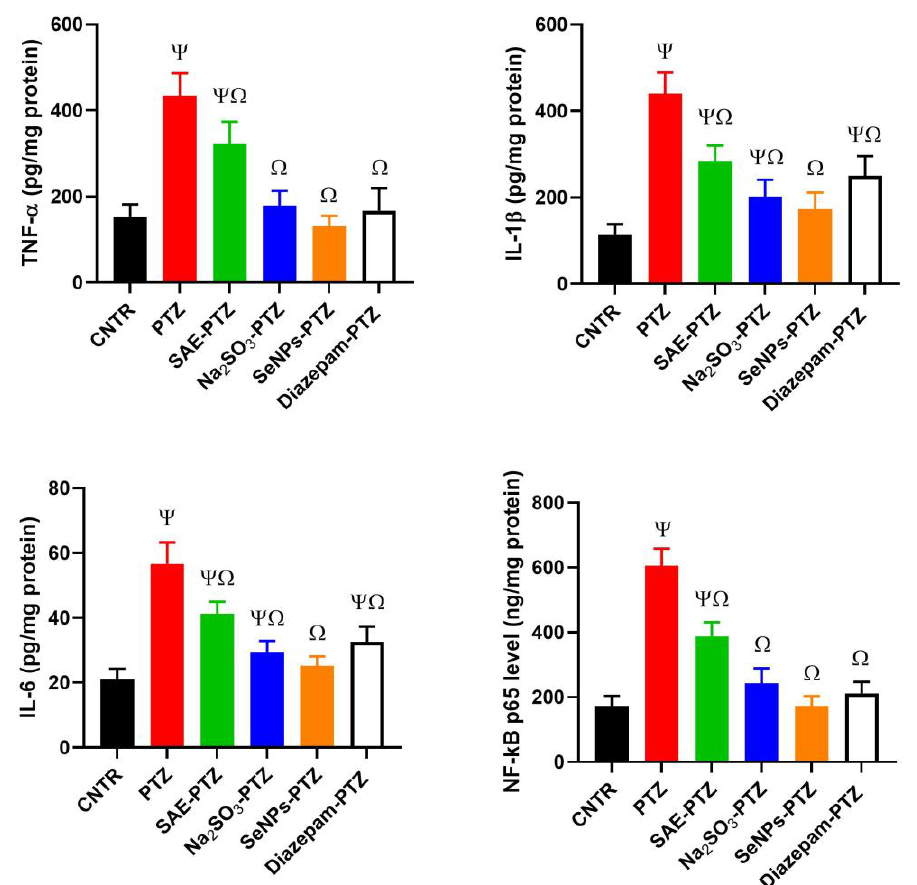
Figure 4. Anti-inflammatory effects of oral administration of Syzygium aromaticum extract (SAE), sodium selenite (Na 2 SeO 3 ), and green synthetized SeNPs using SAE (SAE-SeNPs), indicated by the cortical levels of tumor necrosis factor- α (TNF- α ), interleukin-1 β (IL-1 β ), interleukin-6 (IL-6), and NF-kappa-B (NF- κ B) transcription complex subunit (NF- κ B p65), against pentylenetetrazol (PTZ)-induced neuro-inflammatory response ( n = 8). Ψ and Ω indicate significant differences ( p < 0.05) compared with the control and PTZ-exposed groups, respectively. All values are presented as the mean ± standard deviation (SD).